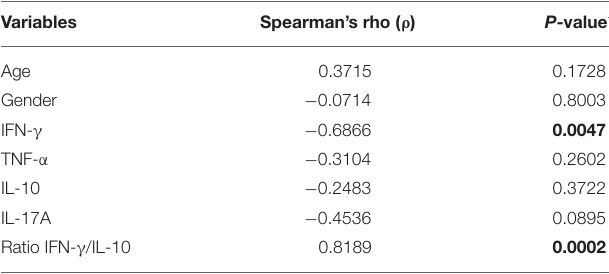
TABLE 3 | Univariate and multivariate comparison between subjects who stayed less or equal than 90 days and subjects who stayed longer than 90 days in an endemic